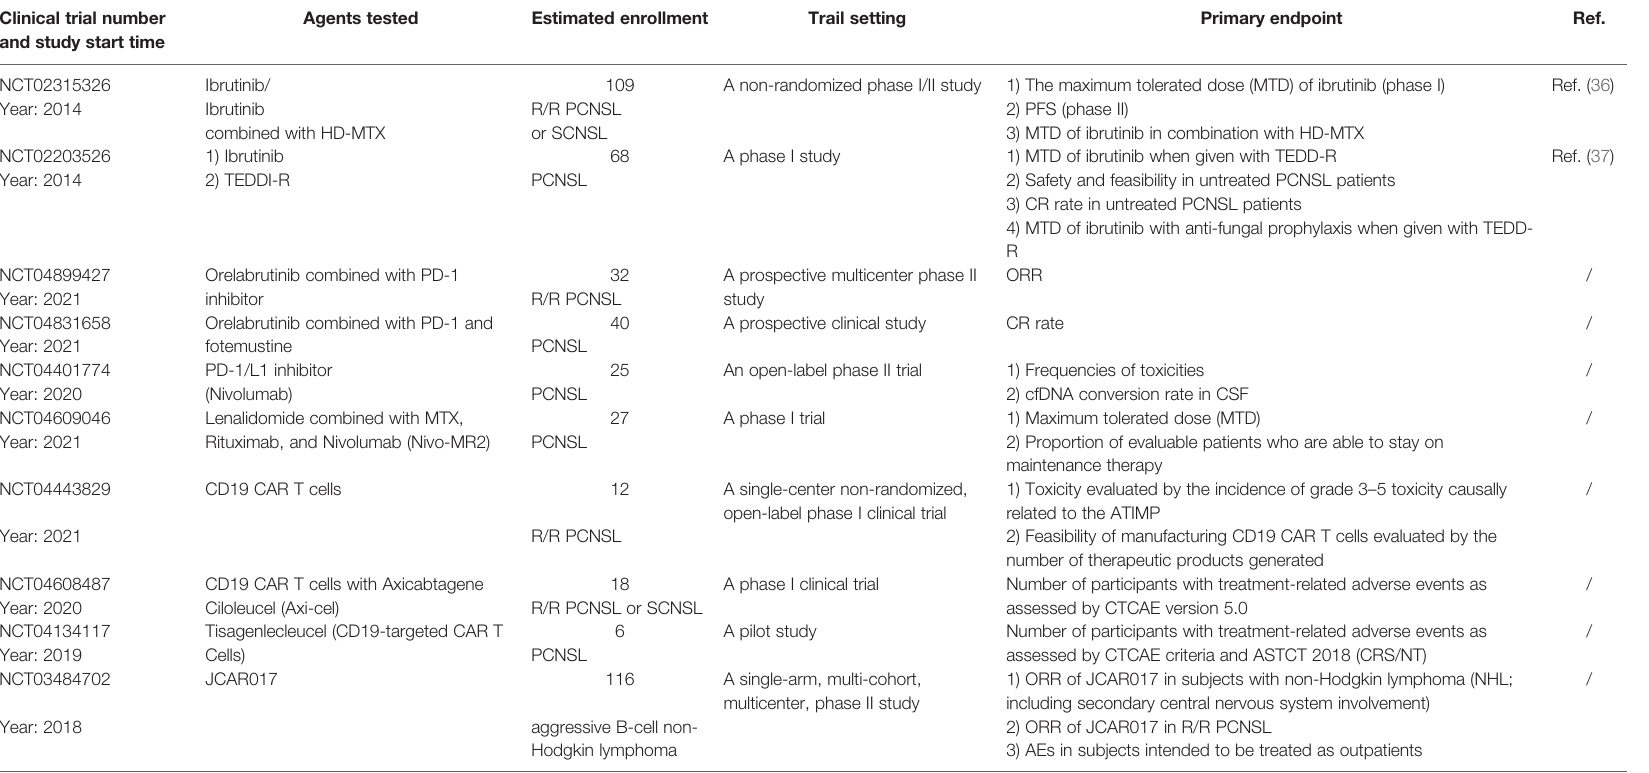
TABLE 1 | Registered ongoing clinical trials for the treatment of PCNSL on